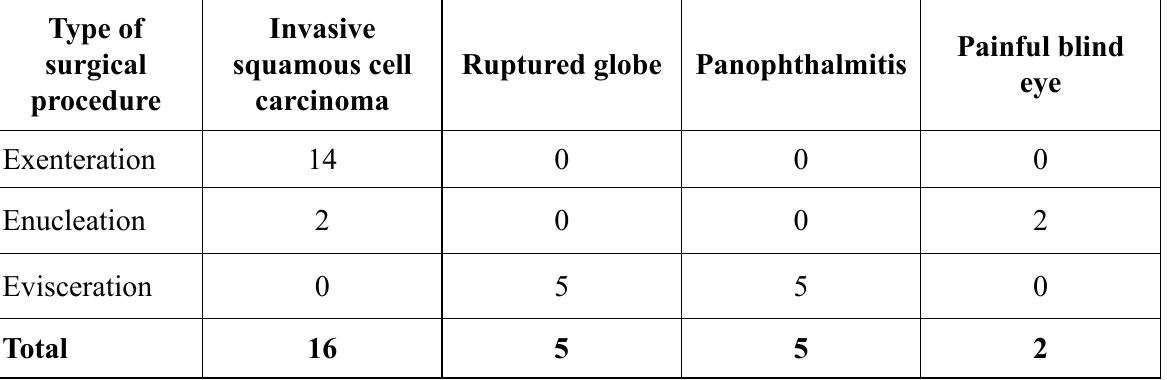
Table 1. Summary of surgical procedures and their indications. Type